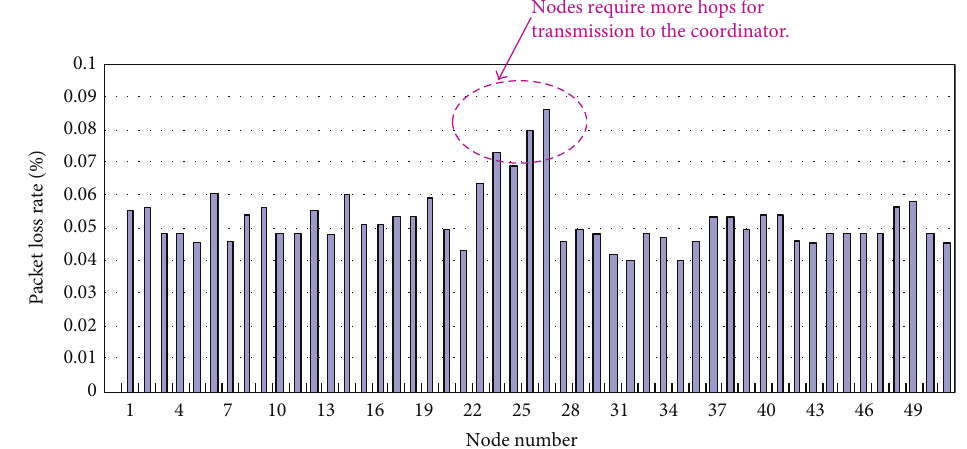
Figure 14: Packet loss rate of each node for seven-day transmission.